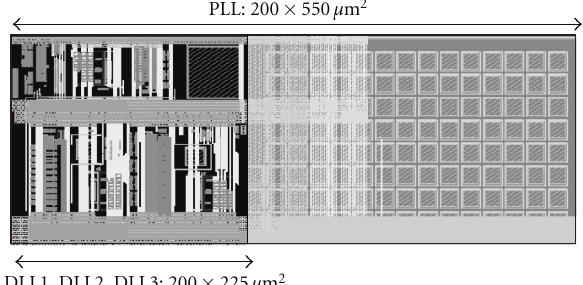
Figure 35: Chip layout. Our fabricated DLL occupies 200 × 225 µ